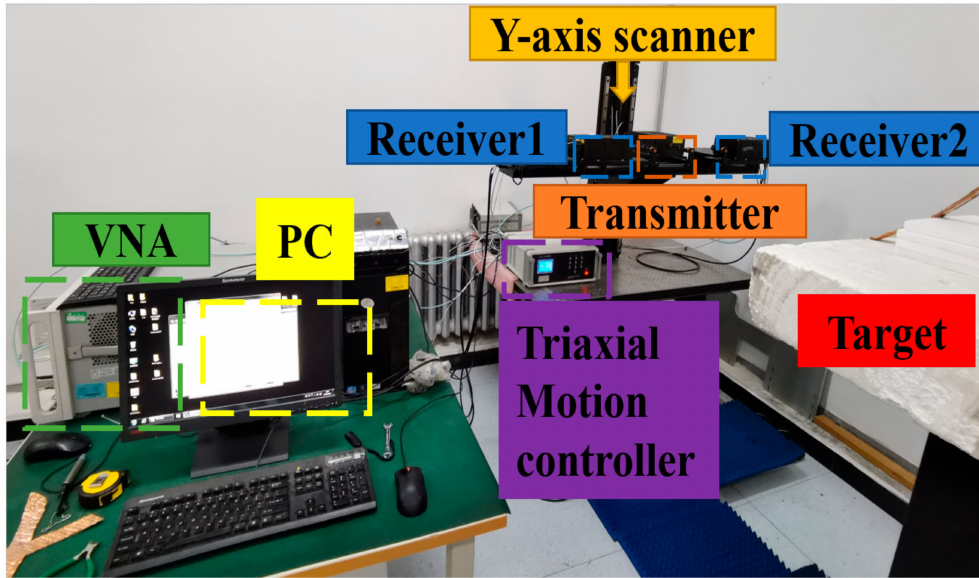
Figure 12. Laboratory experiment setup.